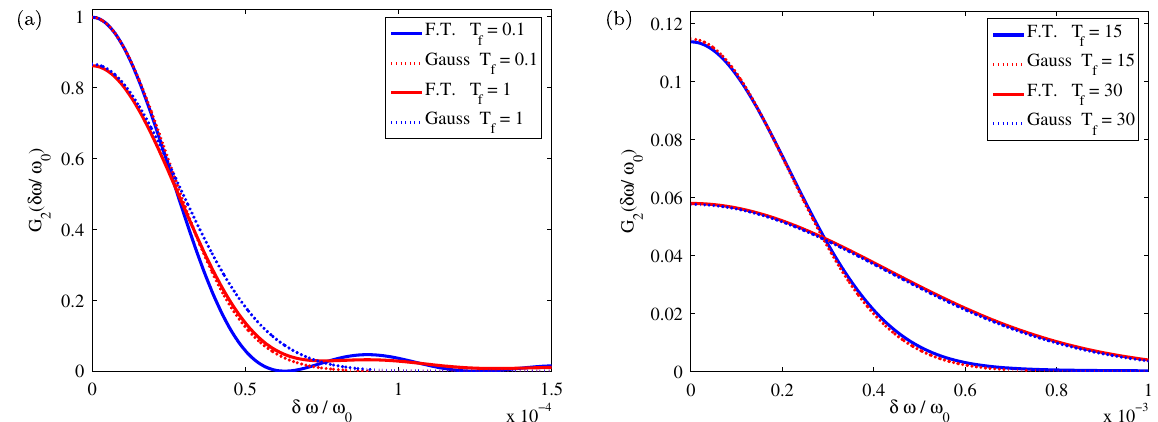
(cid:7) 1 , f (cid:5) 1 , Gaussian and flattop f